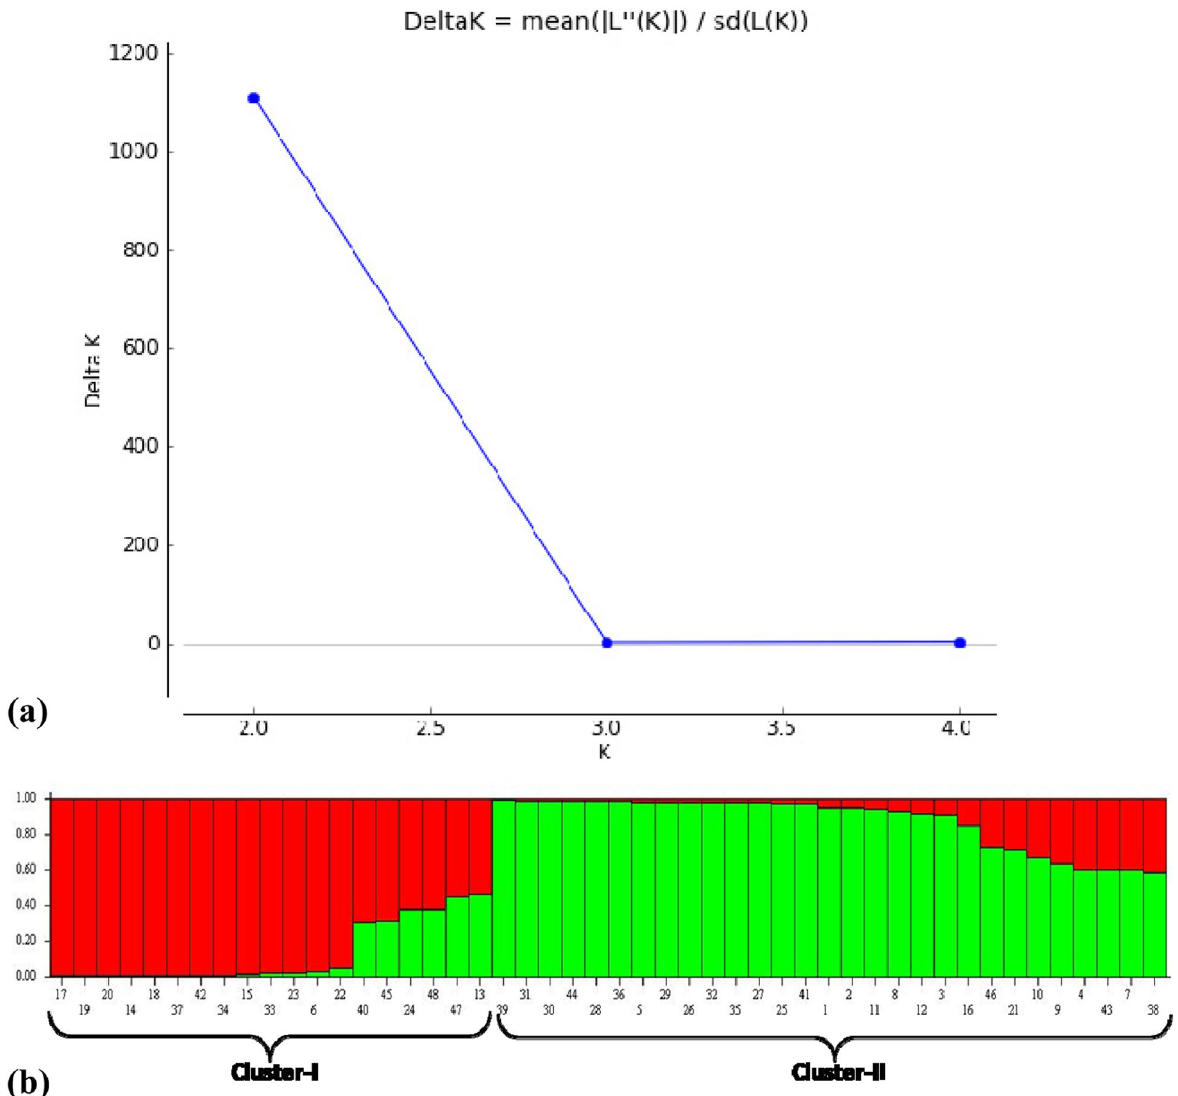
Fig. 5 a Graph showing the best value of k at 2. b Bar plot of 48 accessions of Ziziphus showing two clusters by STRU CTU RE. These clusters represent two populations with admixed